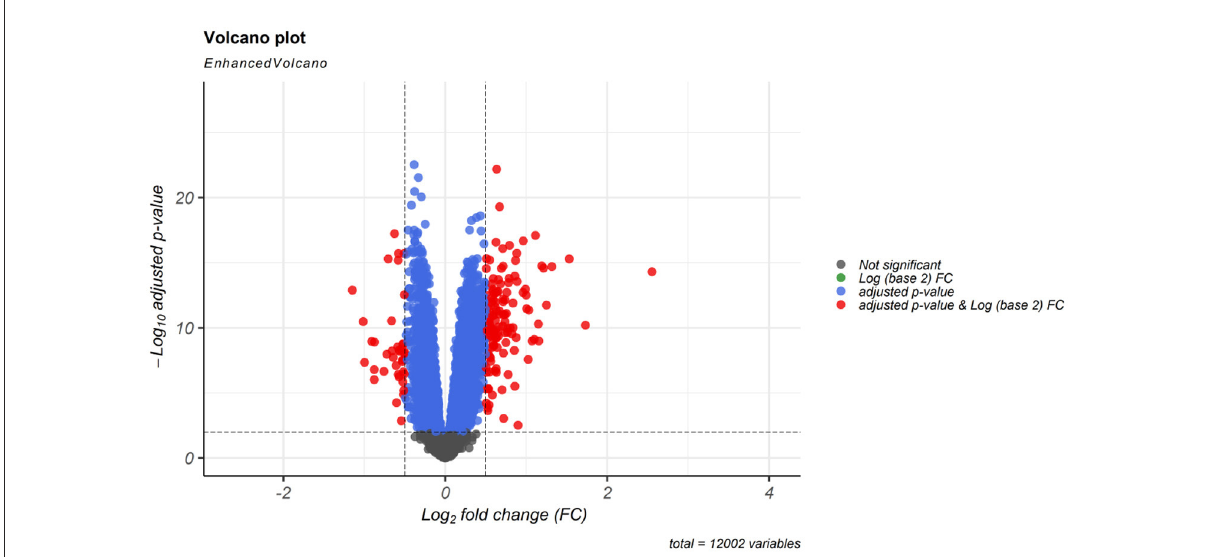
FIGURE1 Differentially expressed mRNAs (DEmRNAs) volcano plot. DEmRNAs were screened using a |(log2FC)| ≥ 0.5 and an adjusted P < 0.001